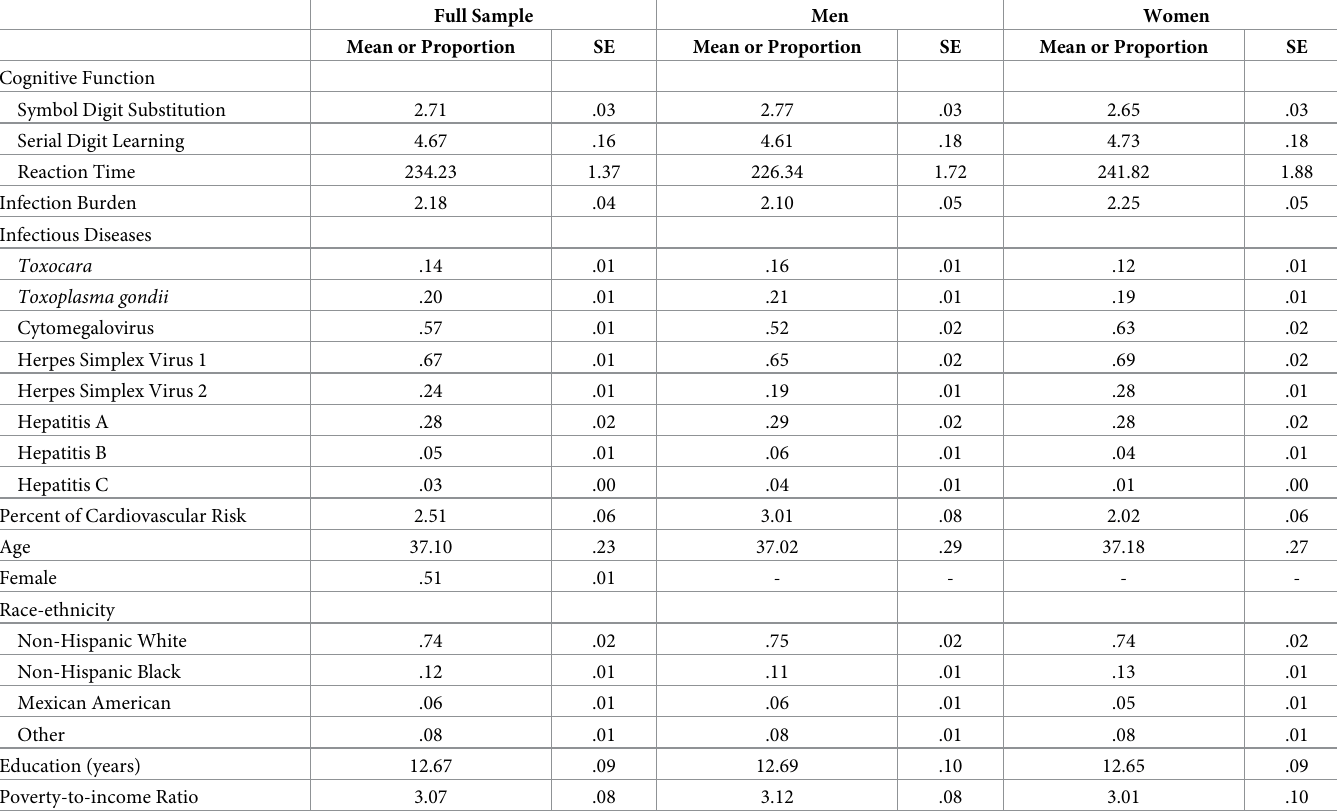
Table 1. Unweighted summary statistics of study